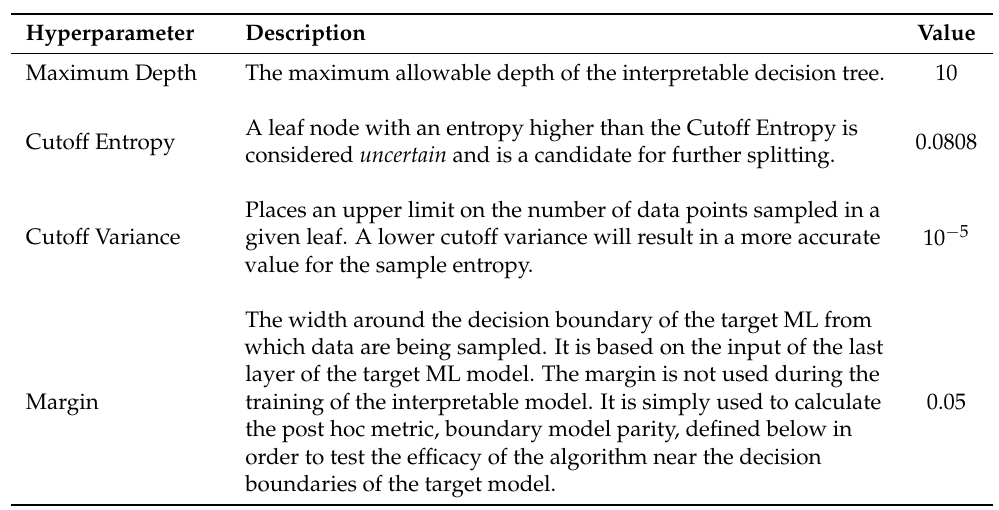
Table 1. Hyperparameter definitions and values used in the study.